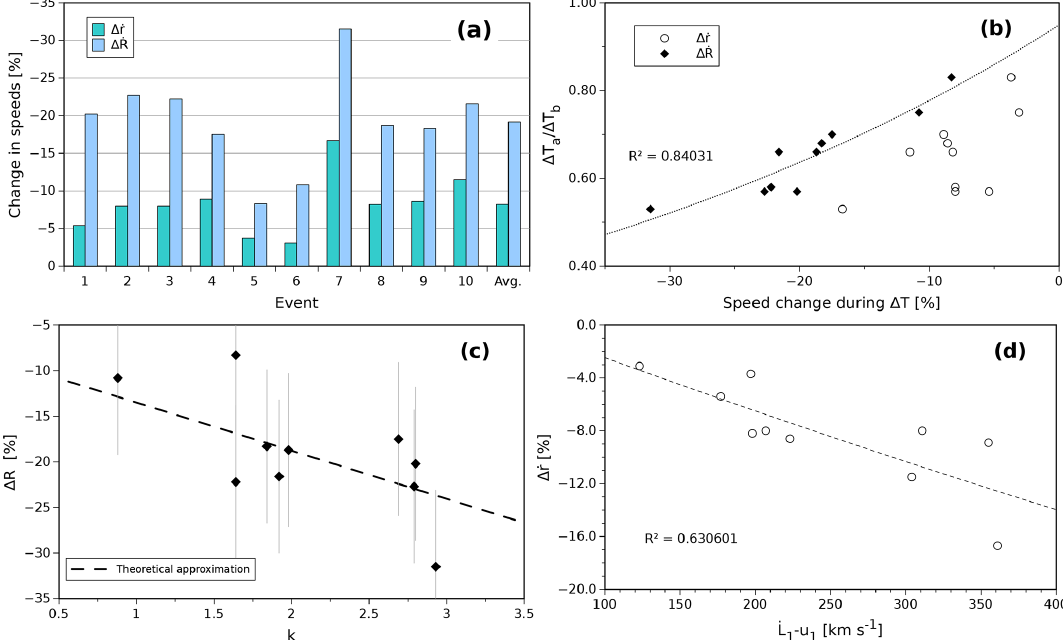
Figure 6. The changes in ˙ R and ˙ r during (cid:49)T . (a) Histogram of the proportional variations of the CME center ( (cid:49) ˙ r ) and expansion ( (cid:49) ˙ R ) speeds with respect to ˙ r( TT r ) . The right-most columns are the average values of (cid:49) ˙ r and (cid:49) ˙ R , respectively. (b) Data dispersion of (cid:49)T a /(cid:49)T b as a function of (cid:49) ˙ R (black diamonds) and (cid:49) ˙ r (open circles) also. The dotted line represents the calculated regression for the tendency with (cid:49) ˙ R as a variable. (c) (cid:49) ˙ R as a function of the free parameter k . The dashed line is the theoretical approximation given by Eq. (17), and the error bars are the difference between the average error of (cid:49) ˙ r and its maximum value, according to (b) . (d) (cid:49) ˙ r as a function of the difference between the calculated arrival speed of the CME leading edge and the ambient solar wind. The dashed line is the tendency regression calculated for the data